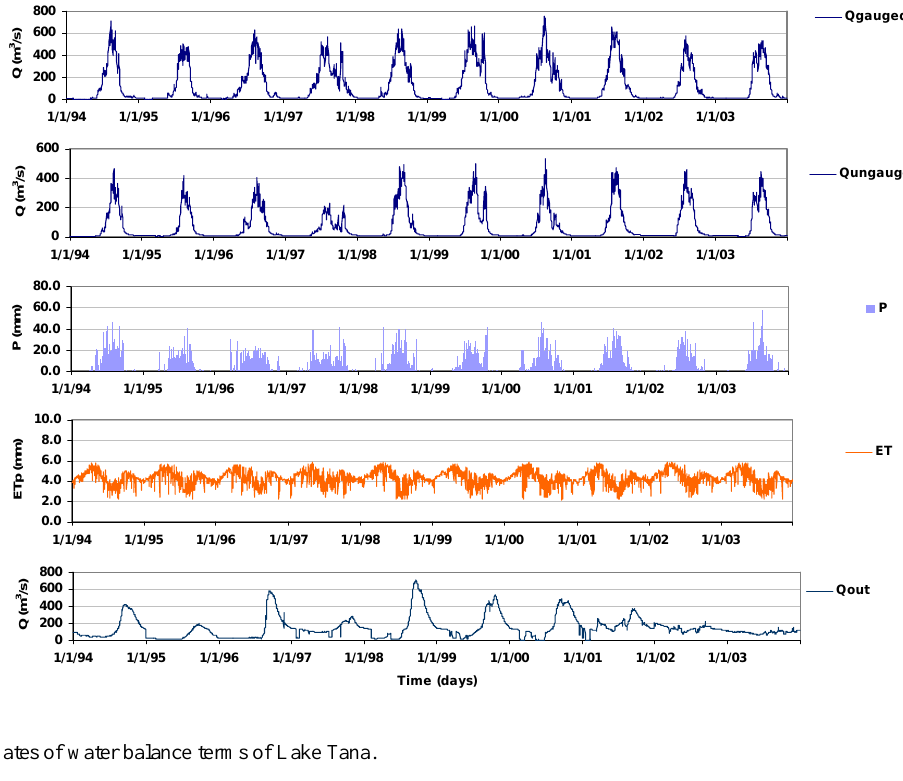
Figure 6: Daily estimates of water balance terms of Lake Tana